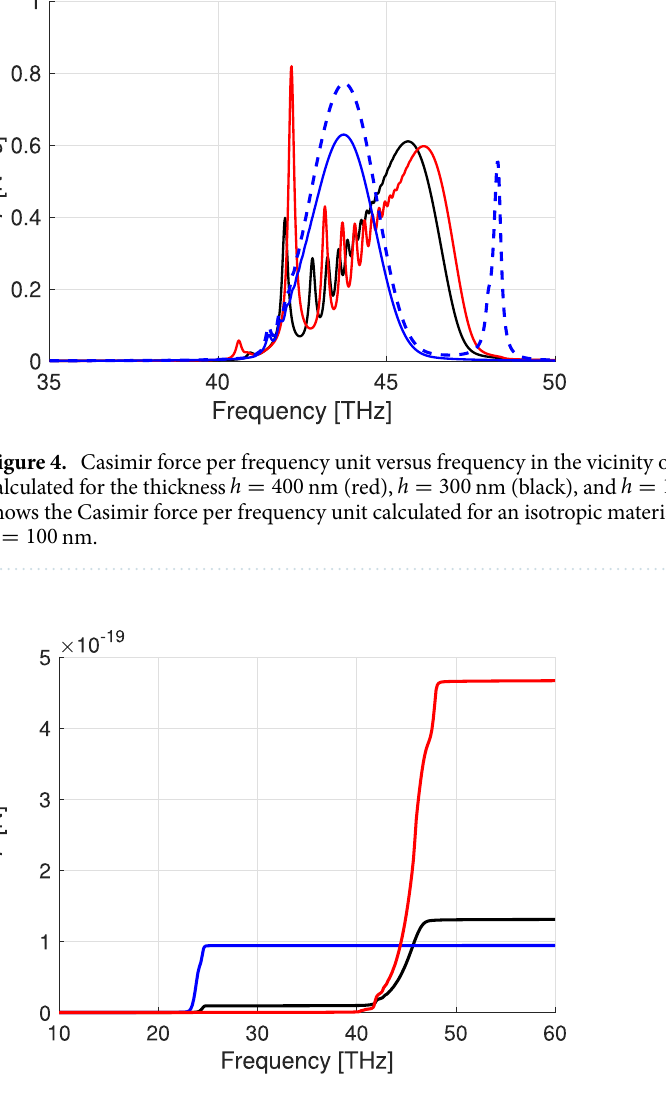
Figure 5. The Casimir force [N] versus frequency calculated for boron nitride (black), for a material with ǫ permittivity ǫ (red), and for a material with ǫ = ⊥